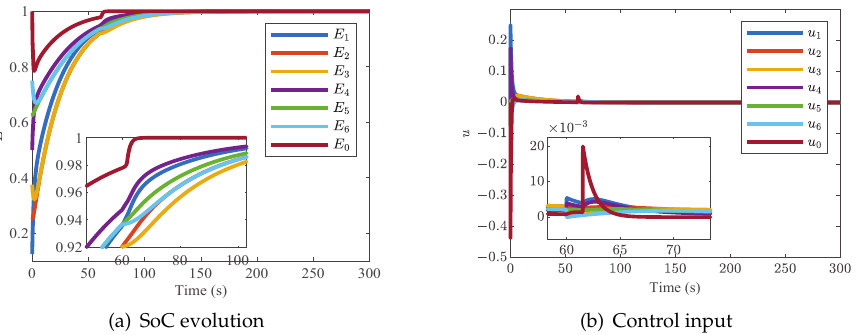
Figure 13. Simulation results under communication graph change with an ME-based smart leader in Case 7.